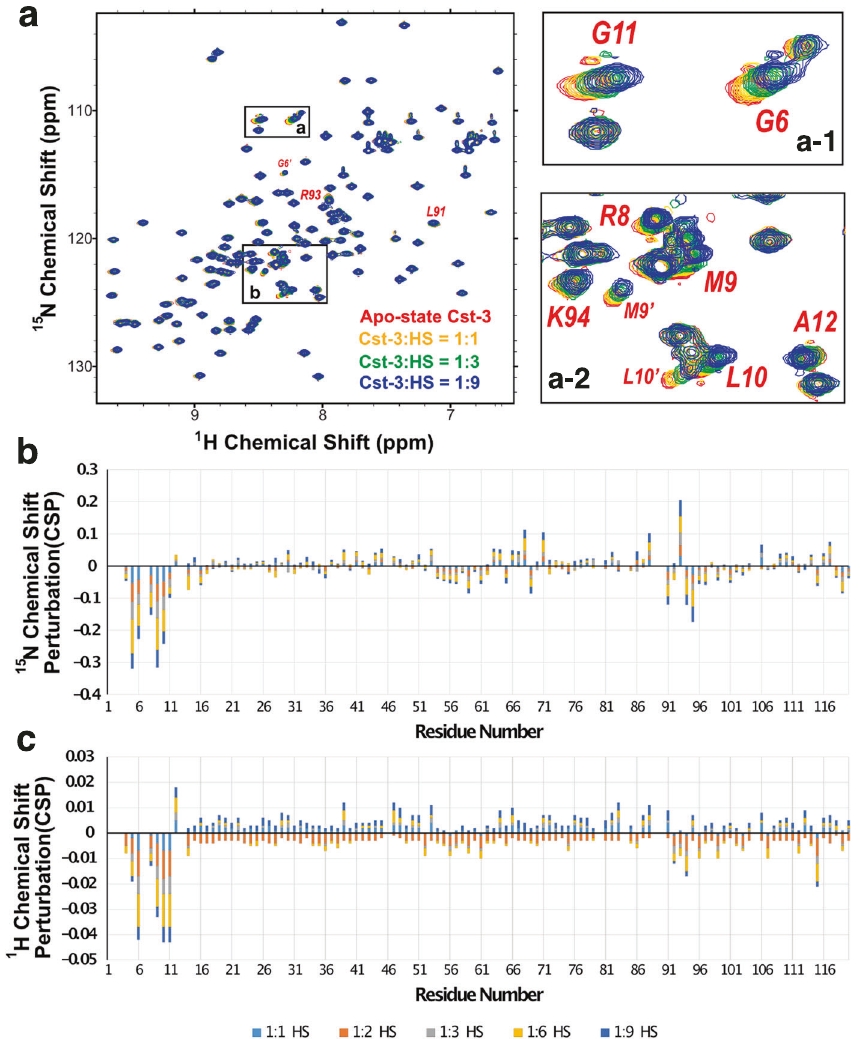
Fig. 4 NMR titration analysis of Cst-3 and HS hexasaccharide identi fi ed two binding sites: the N-terminus and a region around H90. a HSQC spectra of Cst-3 when it was titrated with 1:1 to 1:9 molar ratio of Cst-3: hexsaccharide at pH 5.5. b 15 N-chemical shift perturbation plot of all residues. c 1 H-chemical shift perturbation plot of all residues.